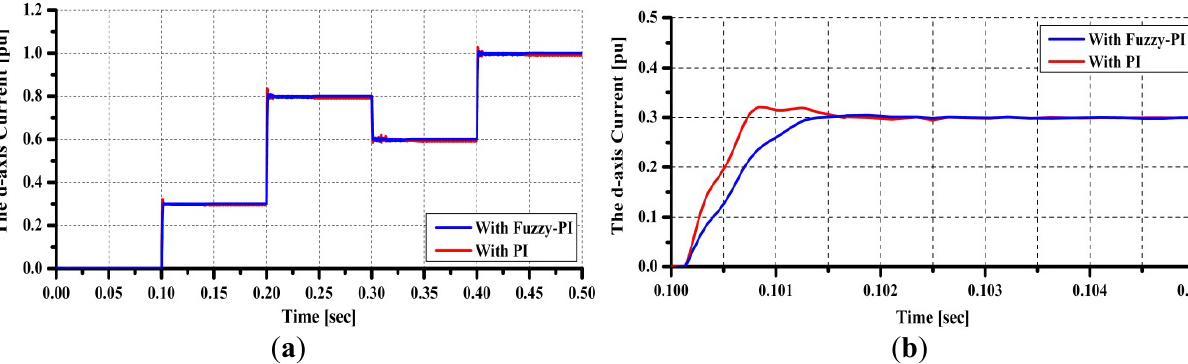
Figure 18. Linear block model analysis. ( a ) Step response; ( b ) Zoom of step response at 0.1